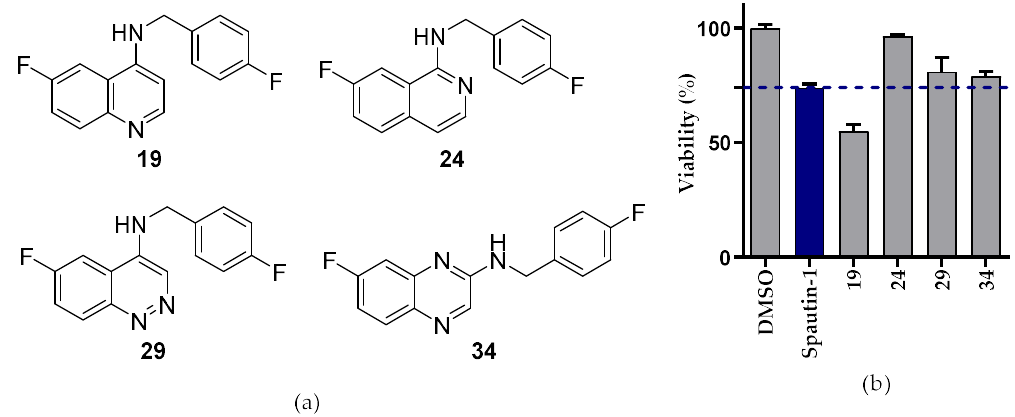
Figure 11. ( a ) Spautin-1 analogues for N -screening; ( b ) viability assay (5 µ M) with Spautin-1 as reference.